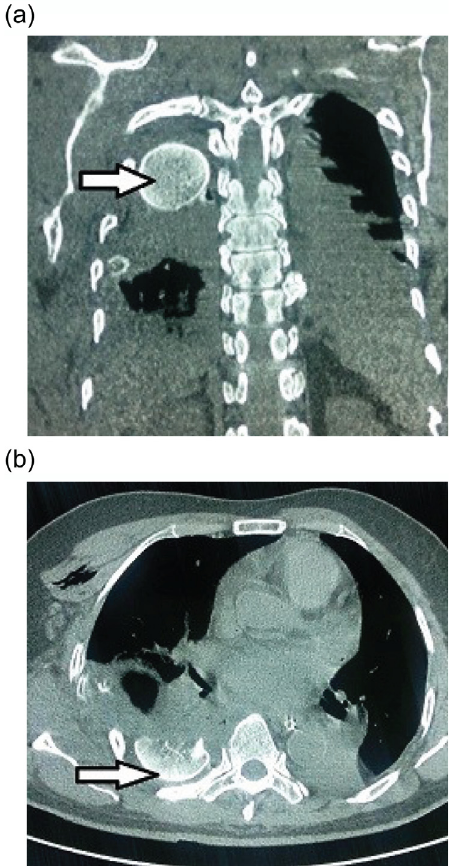
Figure 2. (a) Coronal plane CT showing intra-thoracic humeral head on right side. (b) Axial plane CT showing pleural effusion with right sided intrathoracic humeral head.